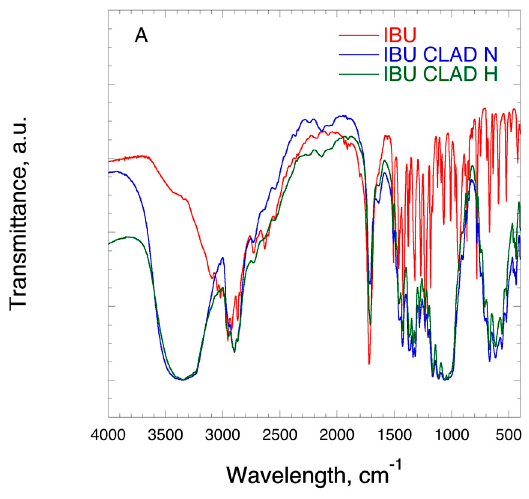
Figure A1. The full FTIR spectrum of IBU, IBU-CLAD-N and IBU-CLAD-H samples.